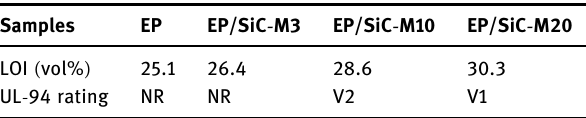
Table 1: The limiting oxygen index ( LOI ) and UL - 94 rating of EP and composite EP/SiC - M Samples